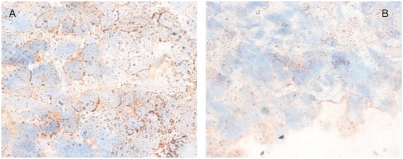
Nuclear morphology of immunolabeled neutrophils in the skin, close to the aspiration cavity.Panel A shows the enlarged nuclear morphology of neutrophils and intense immunolabeling using anti-mouse NIMP-R14 neutrophil antibody (in red) in a skin section of a mouse infested with a Ir-LBP siRNA-treated tick. Panel B illustrates the nuclear morphology and labeling aspect of neutrophils (in red) in a skin section of a mouse infested with a control tick (100×).